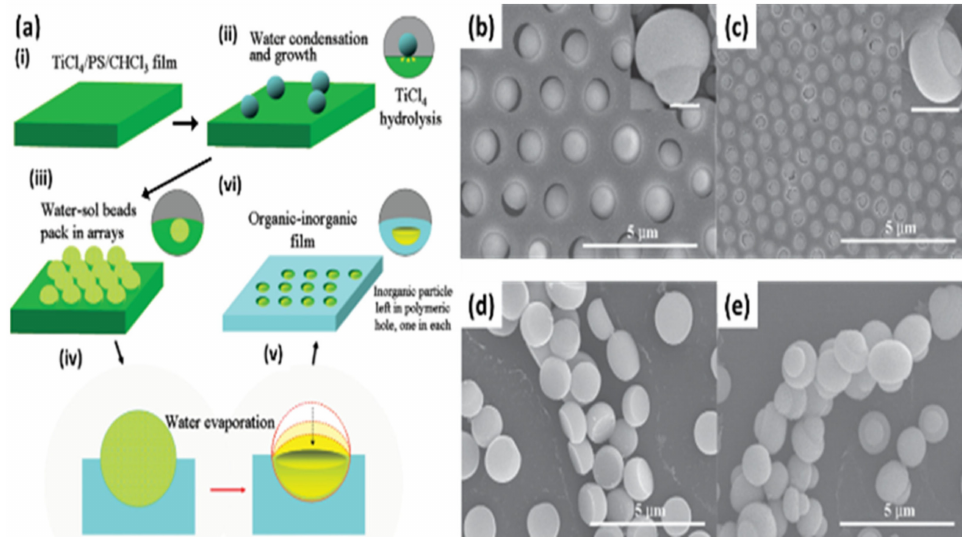
Figure 13. ( a ) Scheme for the formation of highly ordered asymmetrical inorganic particle/polymer composite films by BFs method. ( b , c ) SEM images of the obtained composite film from the TiCl 4 /PS/CHCl 3 solution with different concentrations of TiCl 4 , SEM images of ( c ) hemispherical and ( d , e ) mushroom-like TiO 2 microparticles after calcination of the composite film at 450 ◦ C for 3 h. Reprinted with permission from ref. [102]. Copyright 2011 Journal of the American Chemical